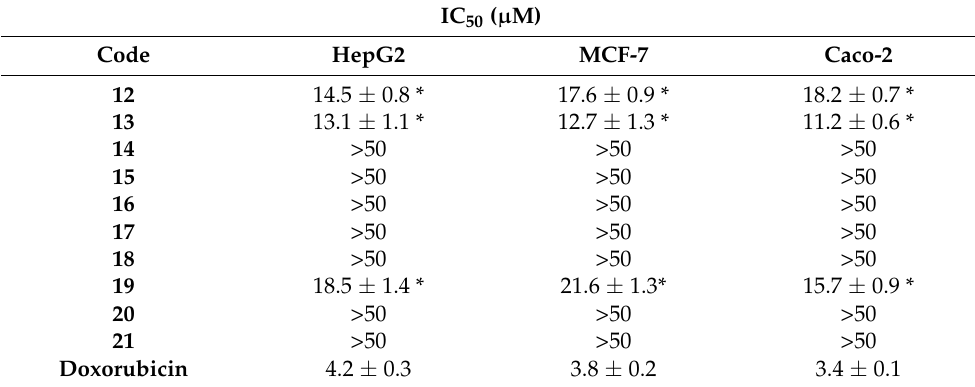
Figure 4. Selected HMBC ( ) correlations of compound